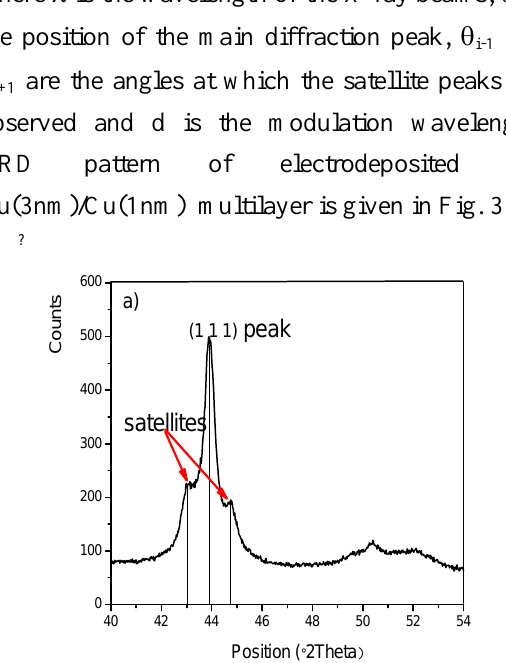
Fig. 3 . XRD pattern of the Ni-Co(3nm)/Cu(1nm) . Two superlattice reflection peaks appear around the (111) Bragg peak of the XRD pattern. A bilayer nominal and real (measured) thicknesses.